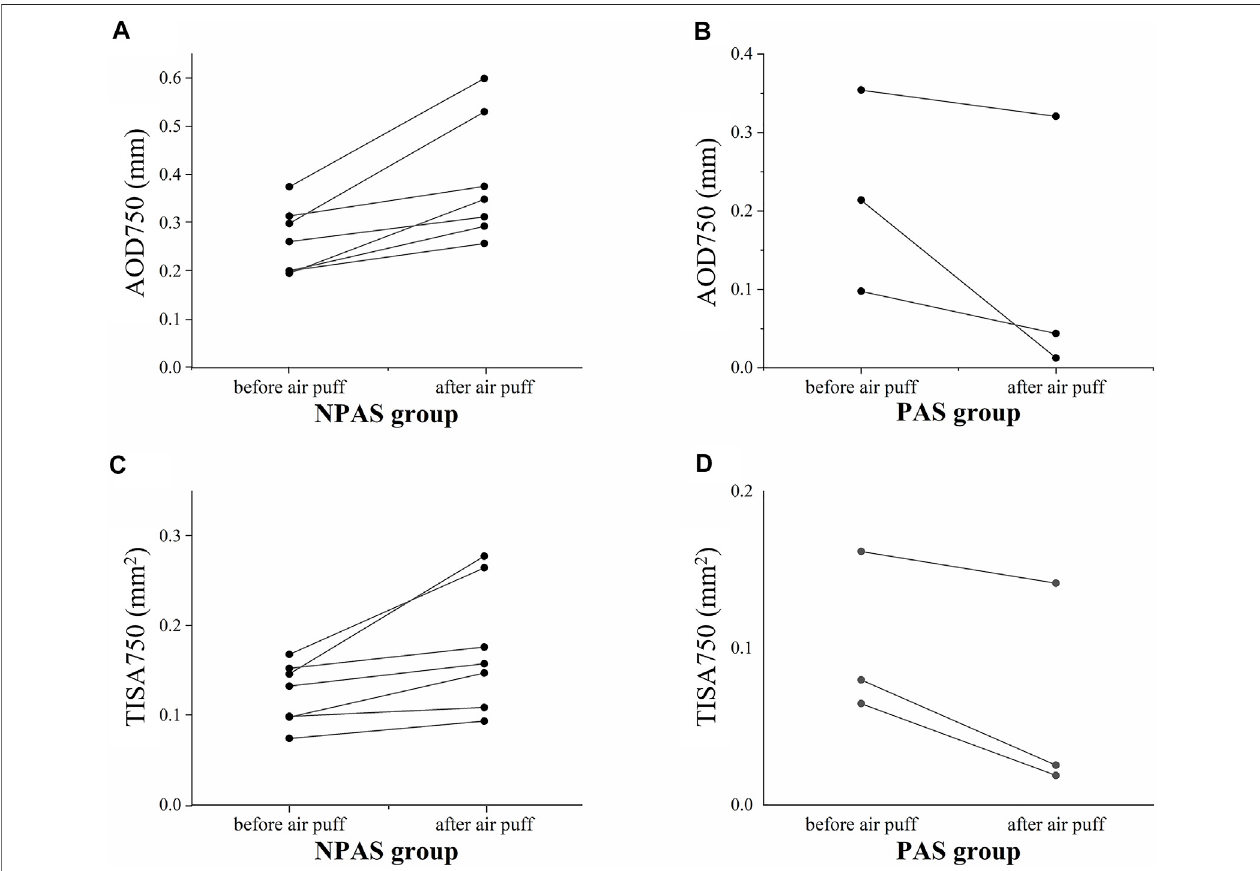
FIGURE6| Variations ofstructuralparametersof10closedACAs ( fi veeyes)beforeandaftertheairpuff. (A) ,AOD750intheNPASgroup; (B) ,AOD750inthePAS group; (C) , TISA750 in the NPAS group; (D) , TISA750 in the PAS group.